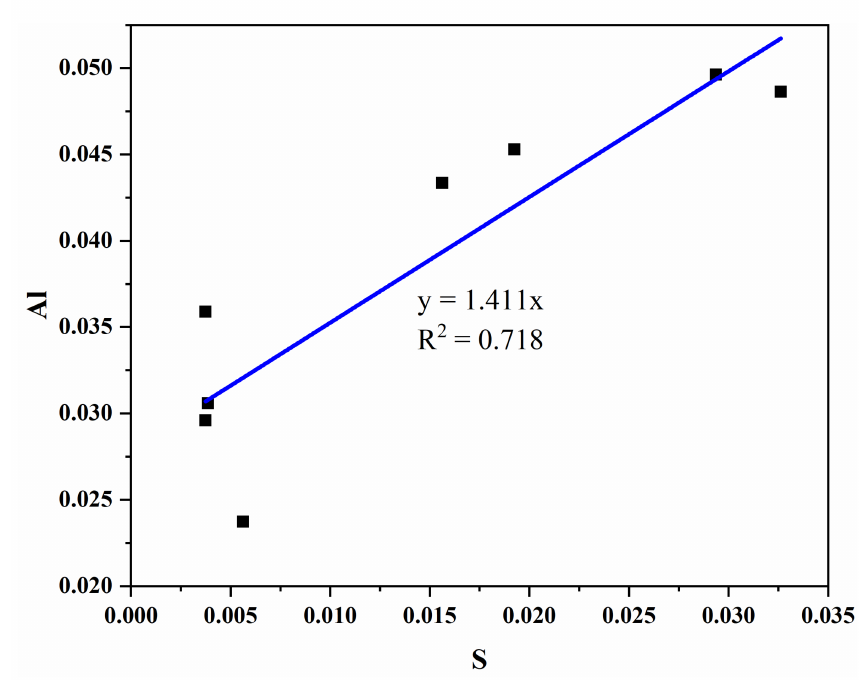
Figure 10. Relationship between the average content of sulfur and aluminum in belite.